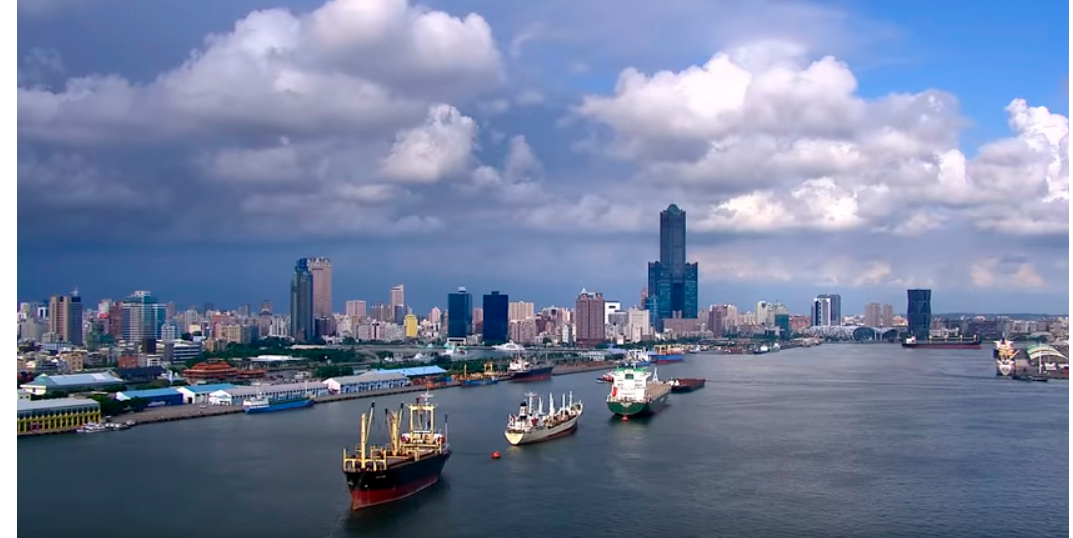
Figure 3. Kaohsiung City harbor-view. (Open Source: Kaohsiung City Government official website [20]).